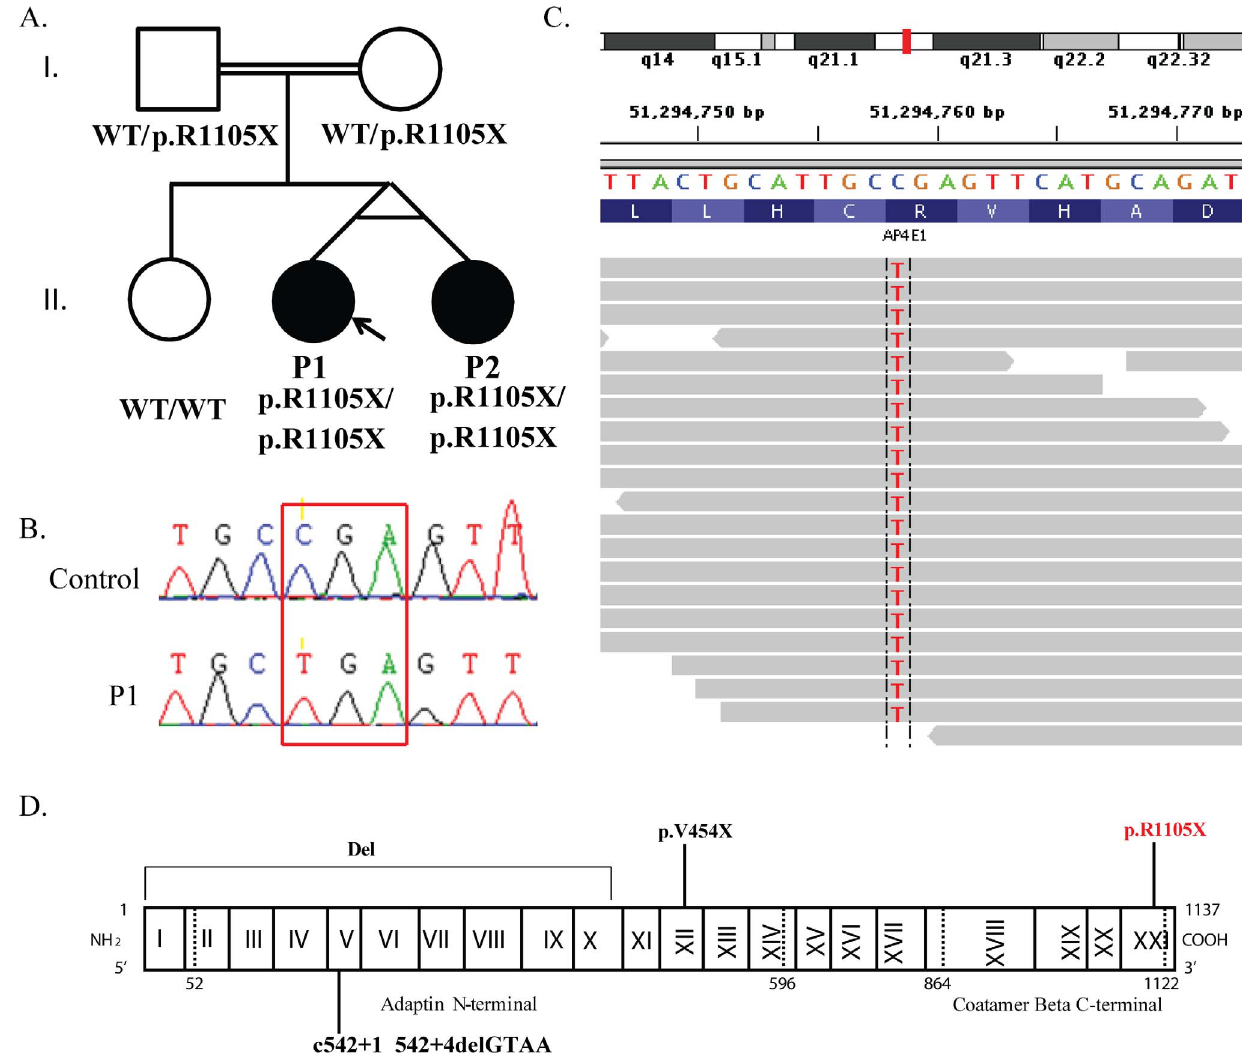
Figure 1. Pedigree and AP4E1 mutation in P1 and P2. A). Pedigree of the family. The segregation of the AP4E1 p.R1105X mutation is also indicated. B). Electrophoregram showing the homozygous mutation of P1 with respect to the control sequence. C). Illumina sequencing reads displayed for patient P1. D). Schematic diagram of the structure of AP-4 e , with the delimitation and numbering of the corresponding exons. The other known mutations of the AP4E1 gene and the mutation described here (in red) are also indicated.